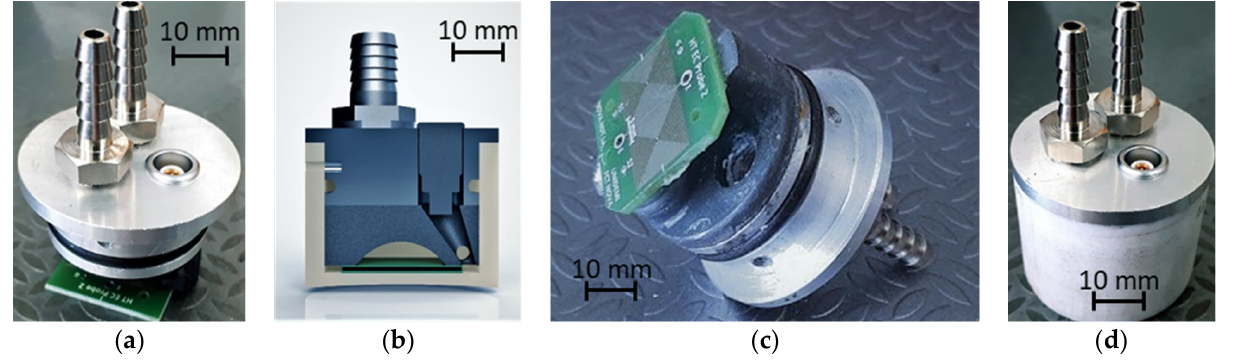
Figure 12. Construction process and chassis parts for the probe developed for the inspection of the pipe base material at high temperature . ( a ) PCB probe and lid assembled; ( b ) probe CAD cross section; ( c ) PCB probe and lid (view from bottom); ( d ) Assembled probe. ( c ) PCB probe and lid (view from bottom); ( d ) Assembled